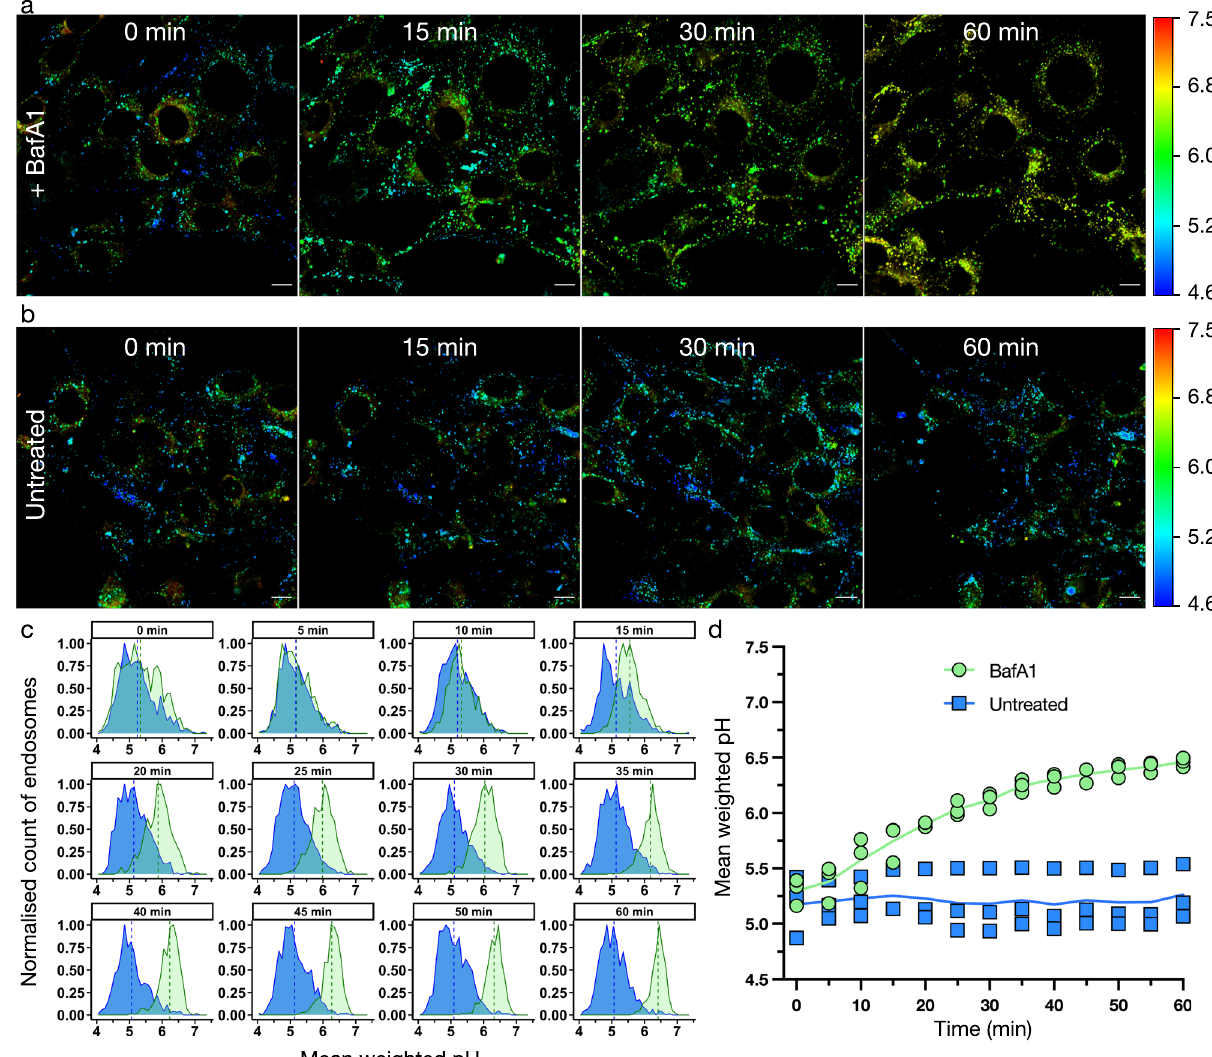
Fig. 4 | mApple pHLIM sensor enables dynamic tracking of intracellular pH in response to treatment with ba fi lomycin A1. a , b Time course fl uorescence microscopy images of NIH-3T3 cells expressing TMEM106b-mApple treated with a 100nMBafA1or b untreated.Imagespseudocolouredbyaphasormask(Fig.1g), pH scale shown on right. c Histograms at the indicated timepoints showing the distribution of pH in endo/lysosomal compartments in a single image. Untreated (blue),BafA1treated (green). The pH of each individualendosome is plotted in the